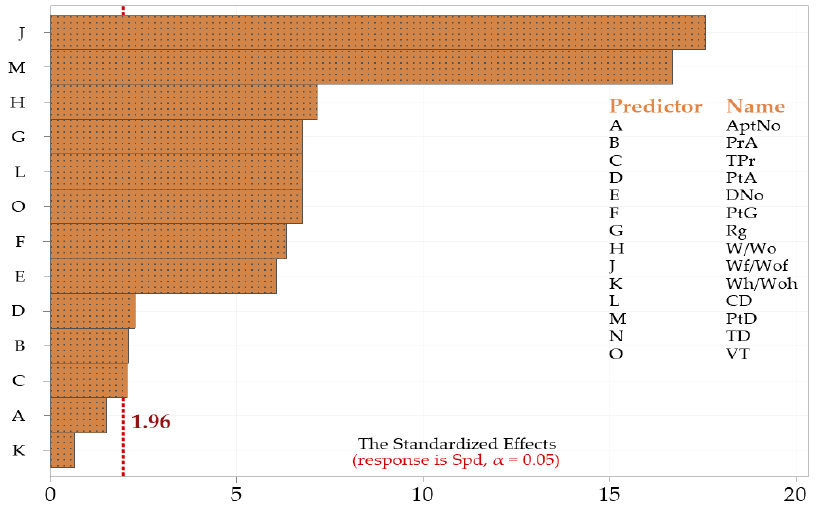
Figure 4. The standardized effect graph of the dependent variable.